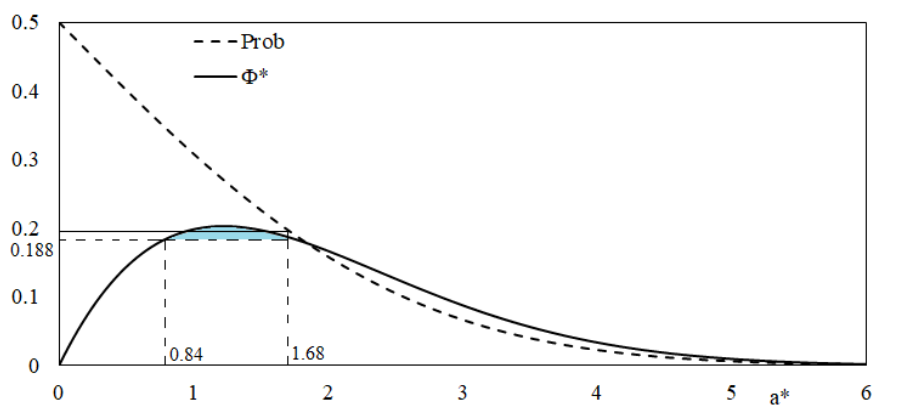
Figure 3. Success probability (29), expected progress (30) and evolution window (blue) of elitist ES on